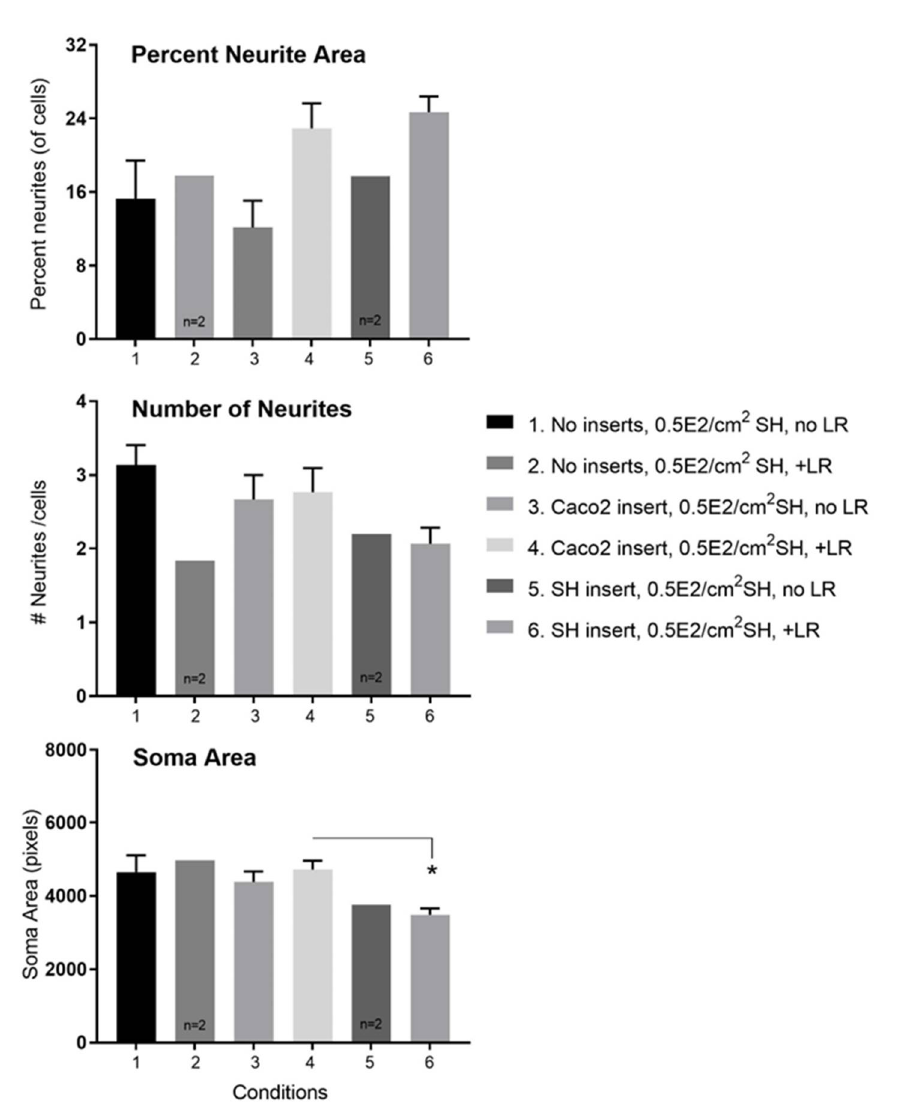
Figure 11. Details of changes induced by transmembrane Lactobacillus rhamnosus (LR) on SH-SY5Y neurons in tri-cultures. The data derive from the same experiment set-up in Figure 10 at 24 h post-LR. Upper panel: The apical addition of LR caused a rise in percent neurite area per total cell volume with either Caco2Bbe1 or SH-SY5Y inserts compared to inserts without LR, or to blank inserts with or without LR. Mid panel: The apical addition of LR did not cause a rise in number of neurites per cell with any inserts. Lower panel: The apical addition of LR to Caco2Bbe1 insets did not change soma volume per neuron. However, the apical addition of LR to SH-SY5Y inserts lowered soma volume per neuron in wells under the SH-SY5Y inserts. # is used to abbreviate numbers (of neurites). Bars are means ± SEMs. * Comparing soma areas under conditions 4 versus 6, p = 0.031 by Tukey’s multiple comparisons test. Regarding overall ANOVA, treatment between columns yielded p = 0.149. Although this slice of time effect alone did not meet criteria for significance, the pattern of higher neurite area in conditions 4 and 6 is a static validation of Figure 10 time course.